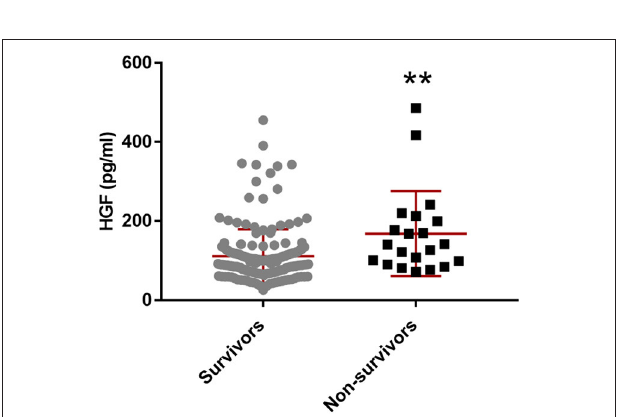
FIGURE 2 | Comparisons of plasma HGF between survivors and non-survivors within 3 months poststroke. The horizontal lines represent median levels and interquartile ranges (IQR). N = 181 in survivors, and n = 21 in non-survivors. ** p < 0.01.